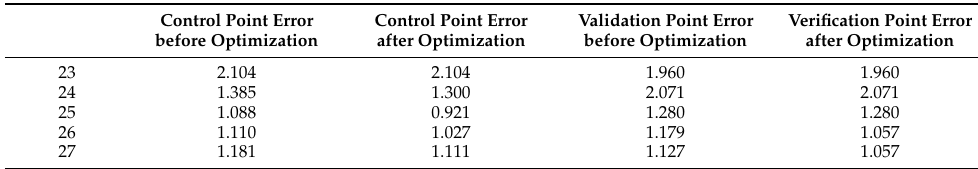
Table 6. Calculation results of grid errors in scene B (unit: